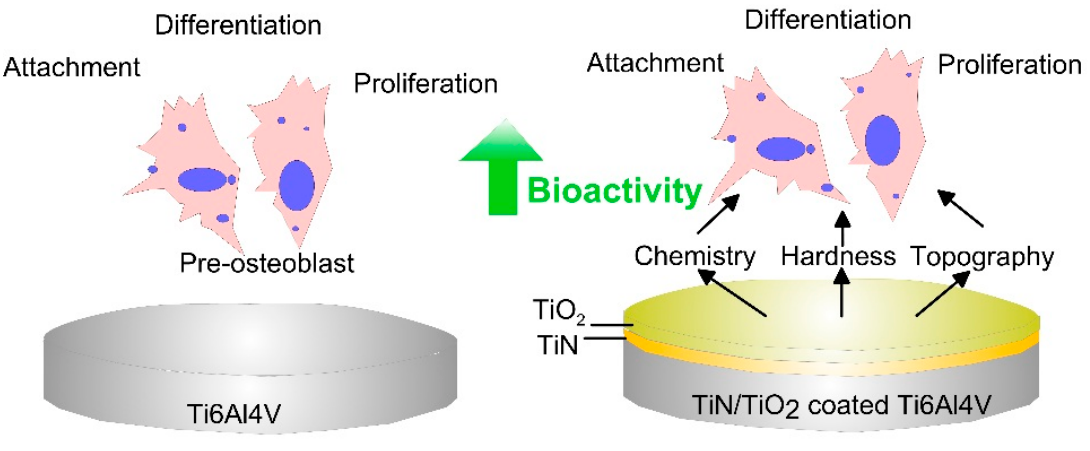
Figure 5. A strategy to improve osteointegration by applying inorganic nanostructured TiN / TiO 2 coatings with enhanced surface characteristics as opposed to bare Ti6Al4V alloy.